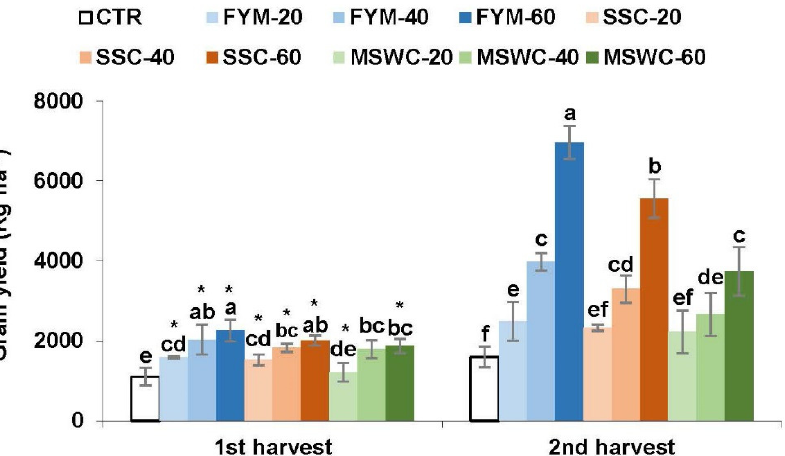
Figure 5. Effect of the soil amendment with different doses (20, 40, 60 t ha − 1 ) of farmyard manure (FYM), sewage sludge compost (SSC) or municipal solid waste compost (MSWC). on the barley grain yield. CTR: unamended soil. Lower case letters indicate significant differences between treatments within the same harvest time. An asterisk indicates significant differences between harvest time within each treatment over time (* p < 0.05).